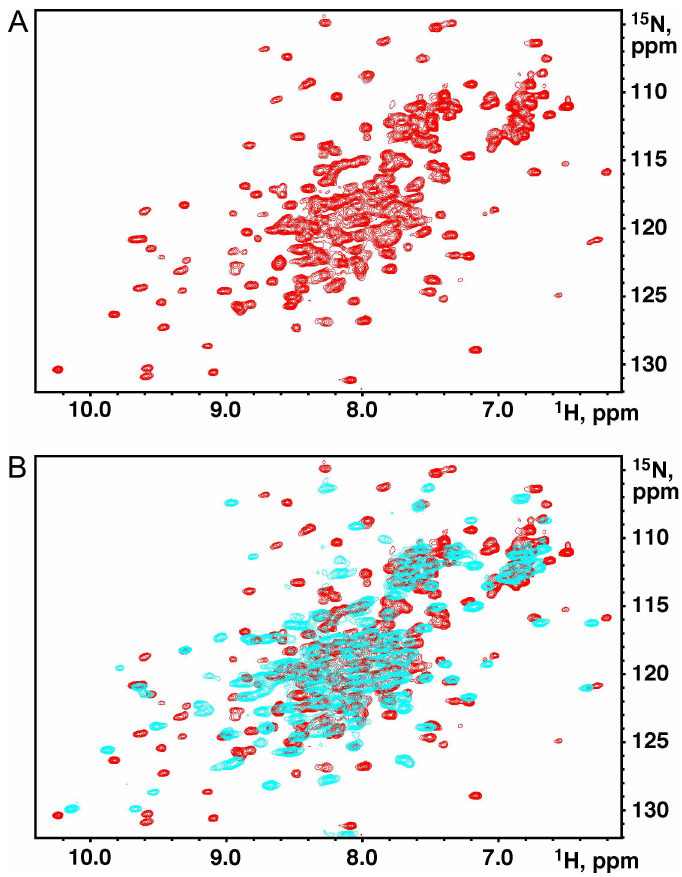
Fig 1. 1 H, 15 N-correlation HSQC spectraof GtgE. (A) GtgE(17–214), dispersion of peaks is characteristic of a well-folded protein. (B) Superposition of HSQC spectra of GtgE(17–214) (red) and GtgE(79–214)